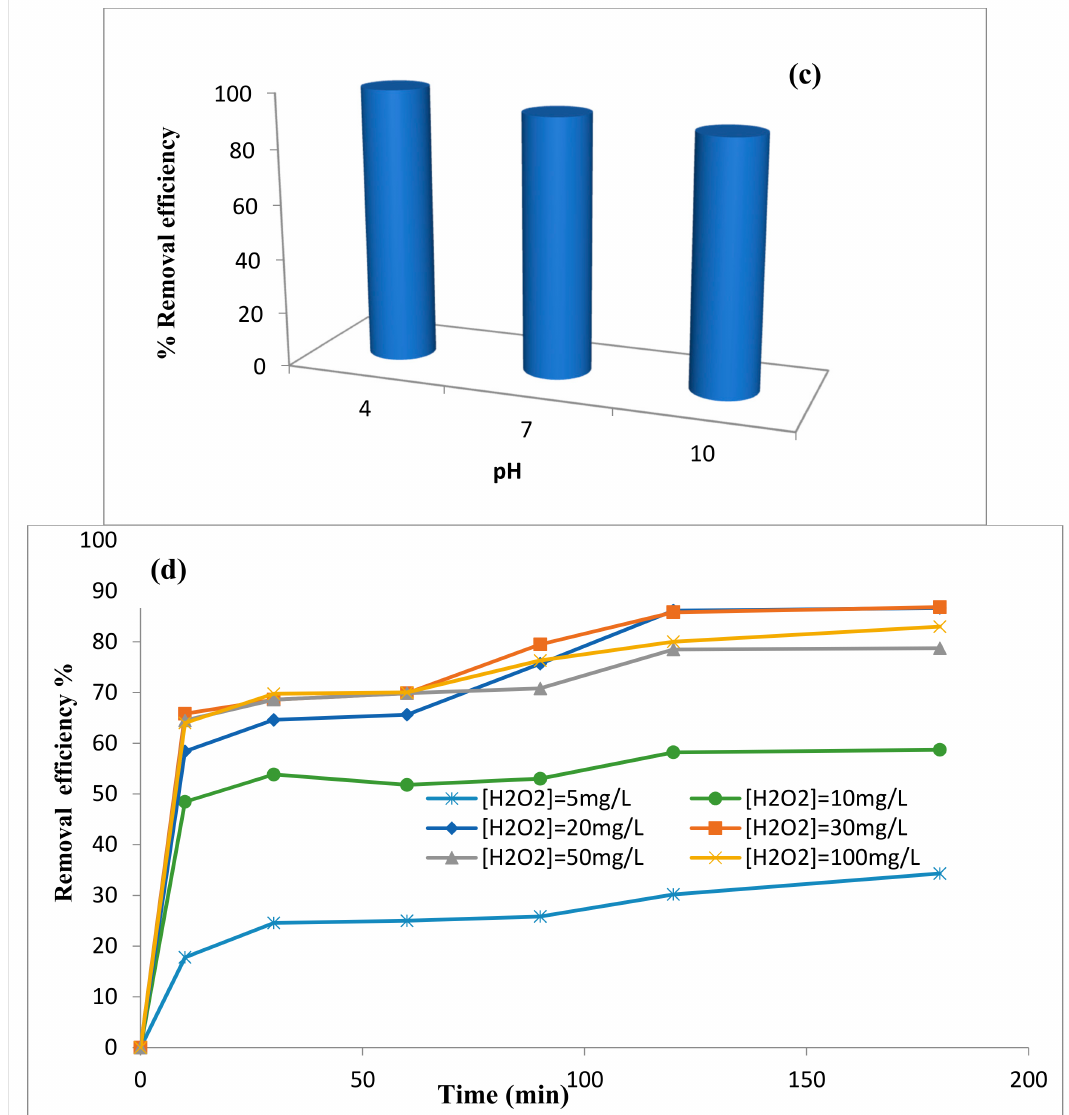
Figure 6. Effect of pollutant concentration ( a ), catalyst dose ( b ), pH of CV solution ( c ), and oxidant concentration ( d ) on the CV dye degradation by